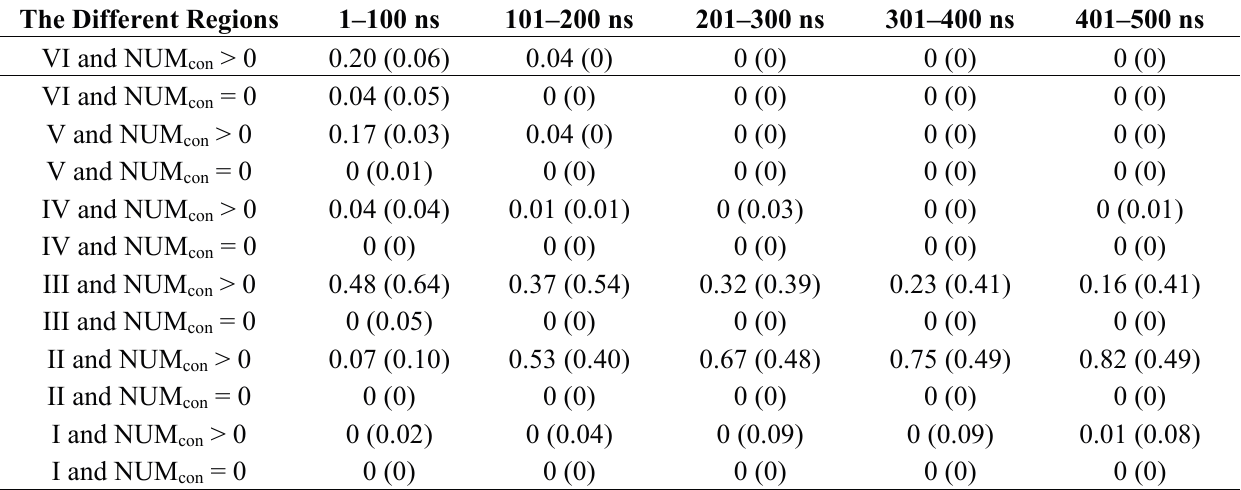
Table 4. The respective probabilities for the α -syn12 dimer fall within the different regions (from VI to I) at the different pH and simulation time. The results at acidic pH are shown in the brackets.